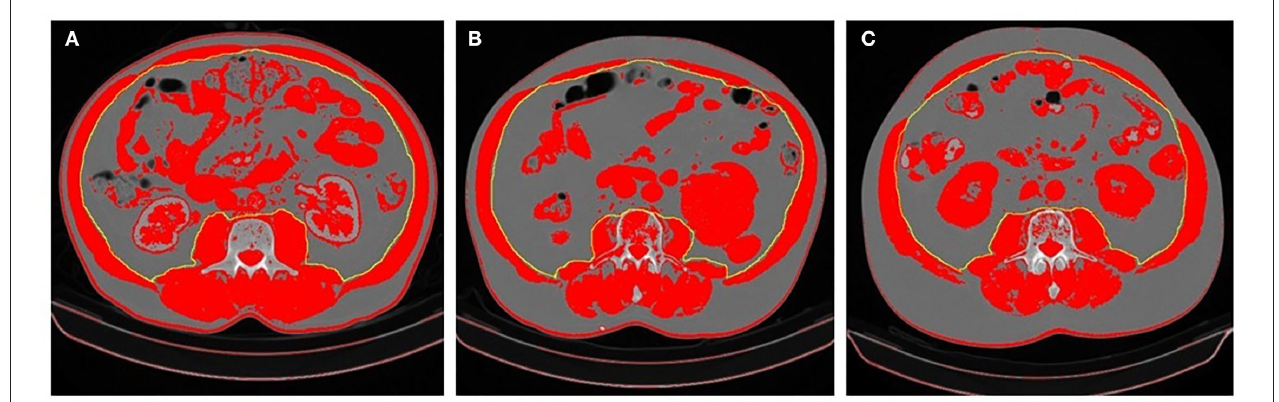
FIGURE 2 | Differences in body composition in three patients. (A) Patient overwright (BMI 28.13 kg/m 2 ) with no sarcopenia (SMI 62.80 cm 2 /m 2 ); (B) Patient overwright (BMI 28.70 kg/m 2 ) with sarcopenia (SMI 45.40 cm 2 /m 2 ); (C) Patient with sarcopenic obesity (BMI 34.51 kg/m 2 and SMI 46.10 cm 2 /m 2 ). Patients (B,C) presented DLT. The areas in red represent values between − 29 and + 150 HU. The SMA was determined based on the area of the psoas major, quadratus lumborum, erector spinae, latissimus dorsi, abdominal oblique muscles , and rectus abdominis muscles . SMI was calculated by the SMA/height 2 .